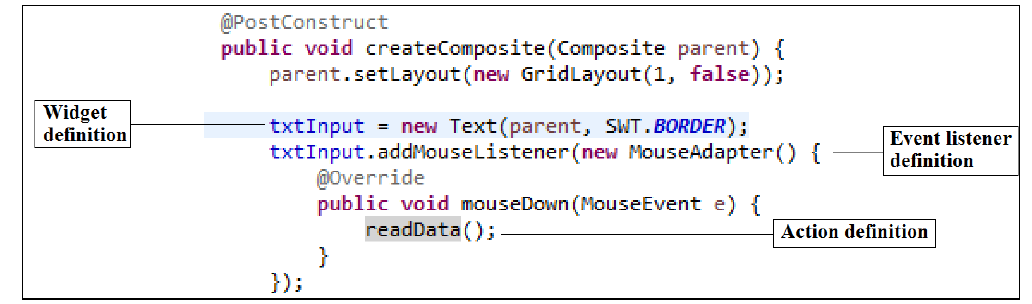
Figure 12 . JFace and SWT components used to define an action in a user interface